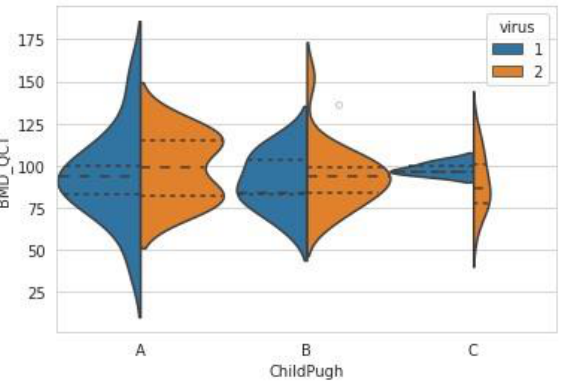
Figure 3. The BMD QCT values according to Child–Pugh classification (1—virally induced liver cirrhosis, 2 = alcohol-induced liver cirrhosis).